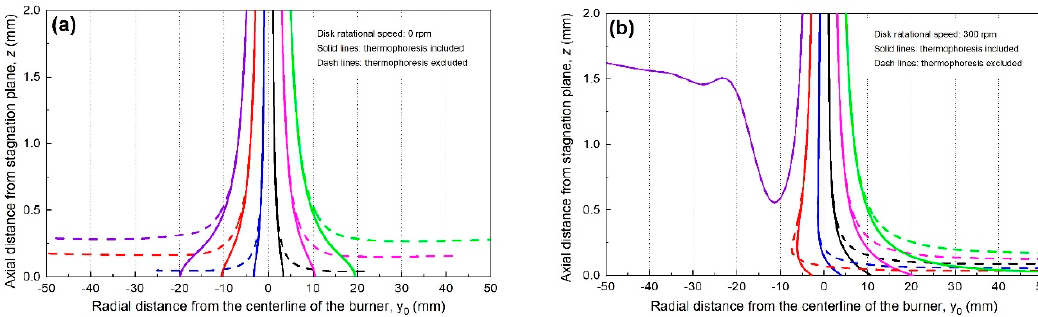
Figure 9. Particle trajectories of the tracked particles when the stagnation surface is ( a ) in stationary and ( b ) ω = 300 rpm (at the same surface temperature).